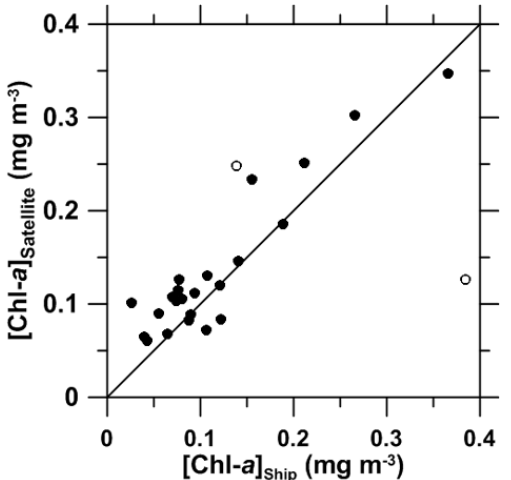
Fig. 6. The satellite observed sea surface chlorophyll a data vs. the shipboard observed data from the same date at the SEATS site. The straight line is the 1 : 1 line.